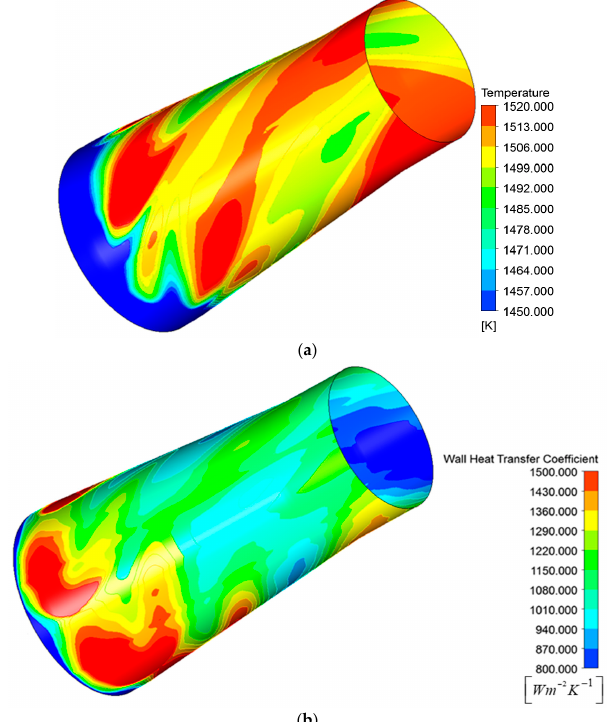
Figure 8 . Parent metal of the inside combustor liner. ( a ) Wall temperature (K) distribution and ( b ) heat transfer coefficient (W/m 2 K) distribution.